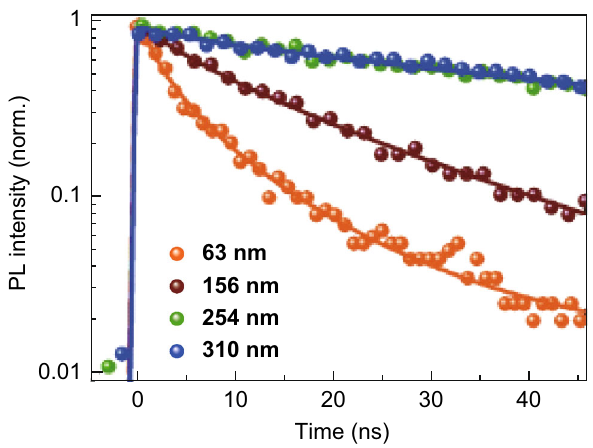
Fig. 20 Thickness-dependent time-resolved PL data illustrate PL decay curve of CH 3 NH 3 PbI 3 films dipped at different concentrations of PbI 2 upon excitation at 517 nm—the solid line corresponds to the results that are stretched exponentially. Reproduced with permission Ref. [203]